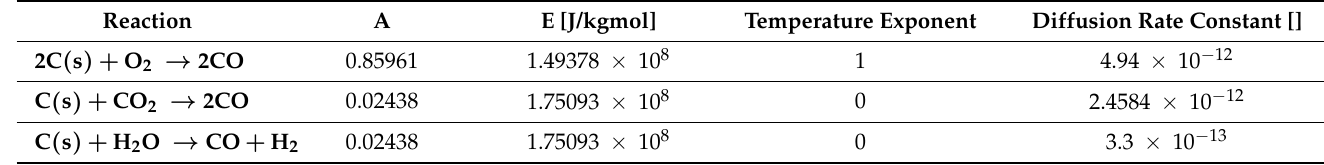
Table 5. Kinetic data for carbon gasification as direct Ansys Fluent input.